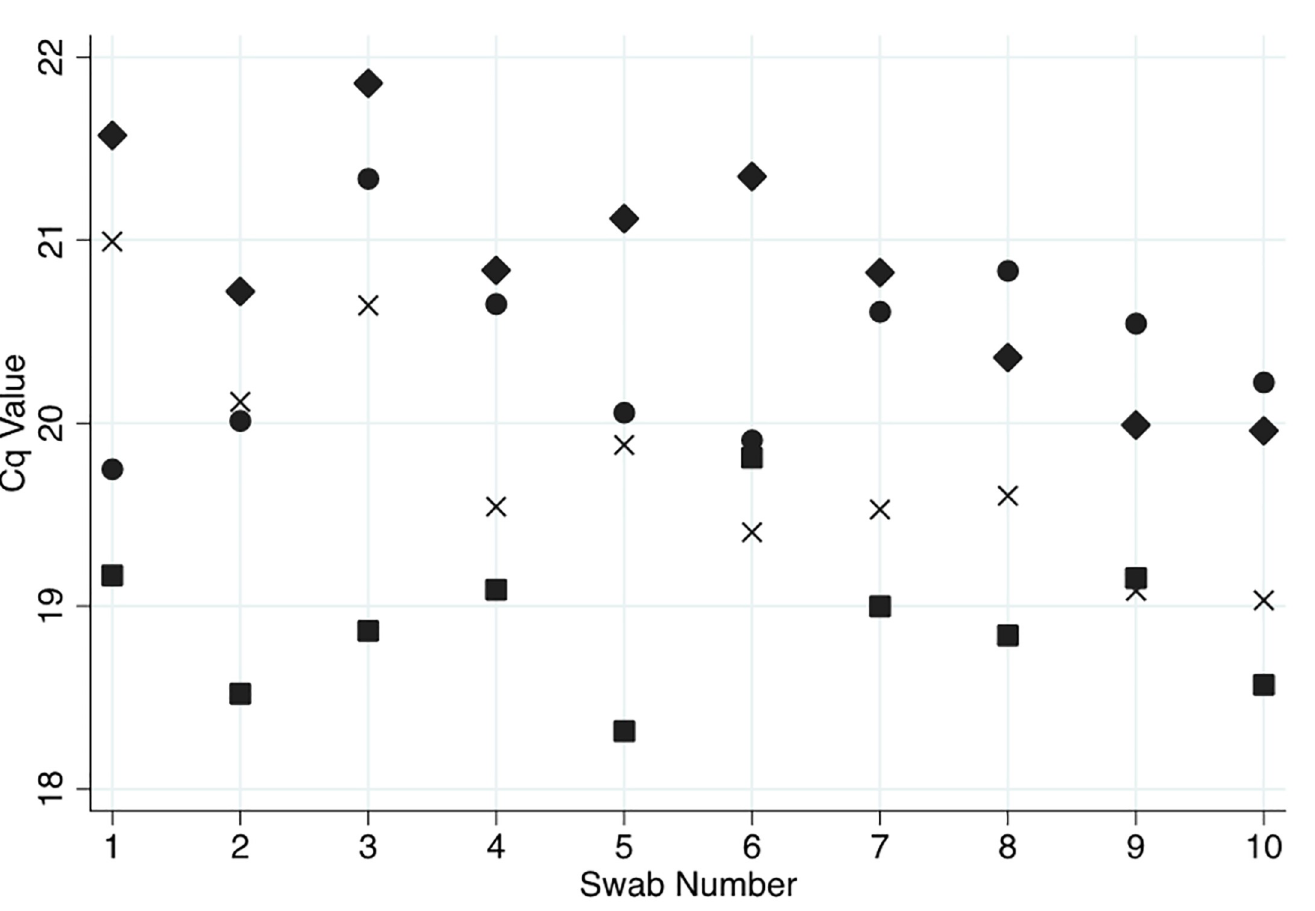
Fig 2. Rapid repeat sampling of individual participants. Ten samples were collected in rapid succession from the tongue dorsa of four healthy volunteers, and tested by conserved bacterial rDNA qPCR. Each individual is represented by a distinct type of symbol.